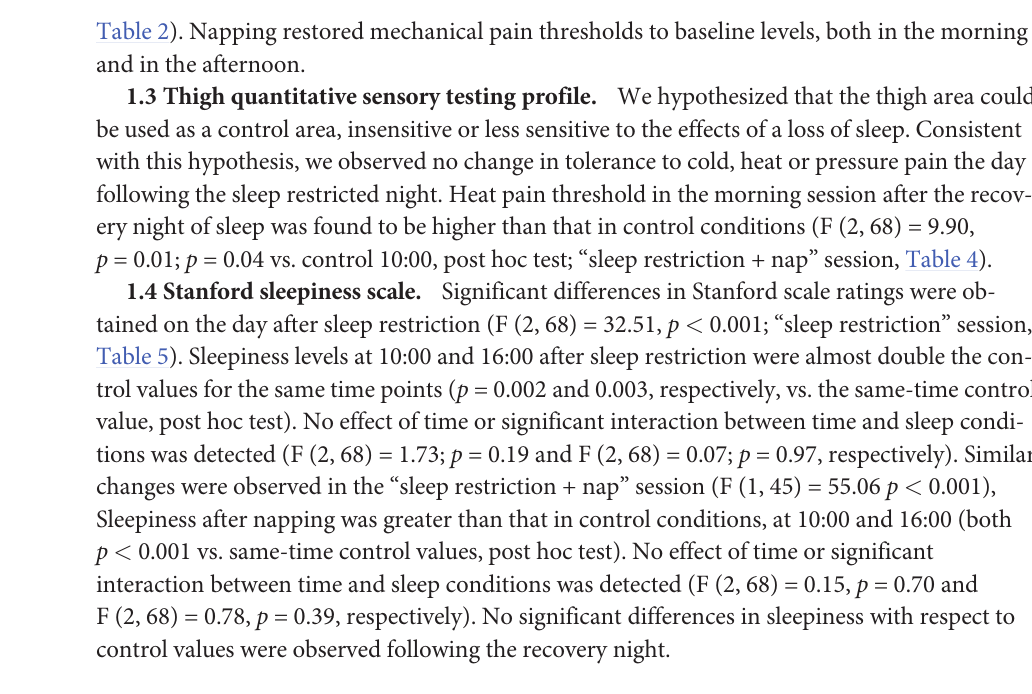
Quantitative sensory testing was performed twice daily, at 10:00 and 16:00, on the lower back area. Warmth and cold detection thresholds, and the thresholds for heat, cold and pressure pain were assessed in control, post-sleep restriction and recovery conditions in the “ sleep restriction ” and “ sleep restriction + nap ” sessions for each subjects. Mean ±